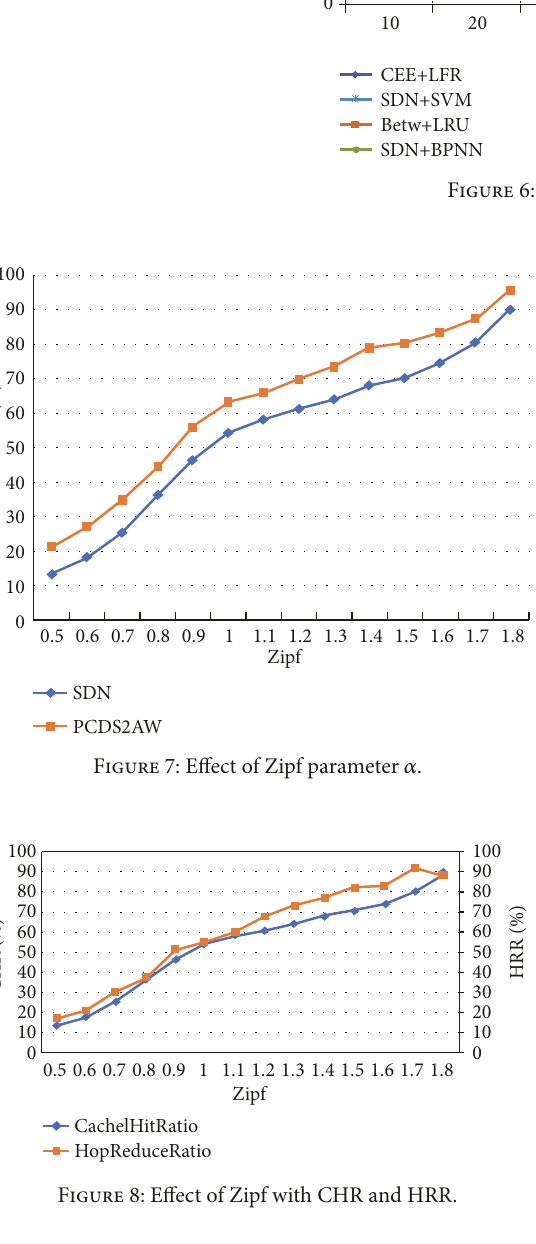
than SDN. The SDN+BPNN cache hit rate reach 64.2% and 76.4%. The PCDS2AW achieves the best than others; CHR reaches 69.6% and 80.3%,